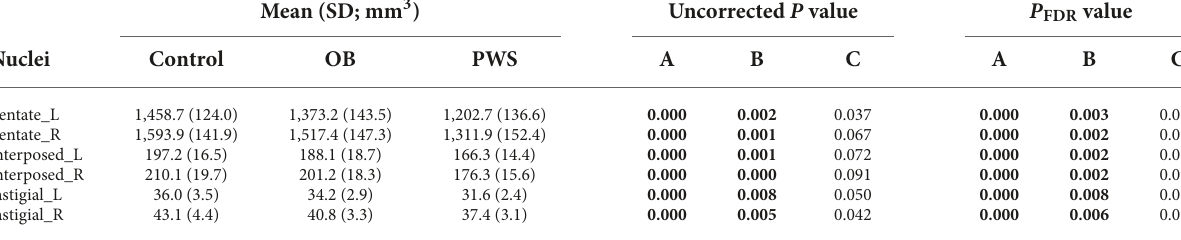
TABLE 4 Deep cerebellar nuclei volume of each group and P value of group comparisons.